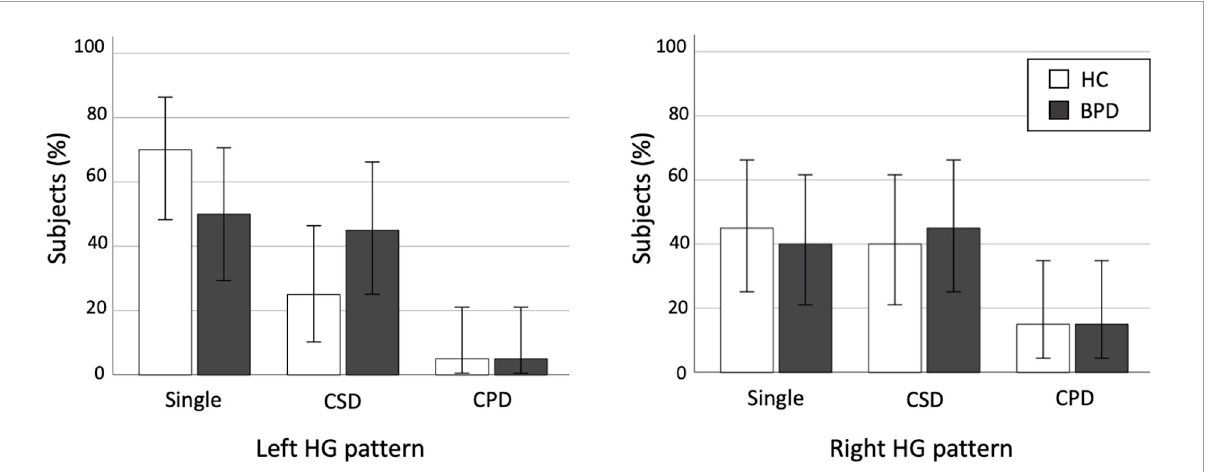
FIGURE2 Distribution of Heschl’s gyrus (HG) duplication patterns in the healthy control (HC) and borderline personality disorder (BPD) groups. CPD, complete posterior duplication; CSD, common stem duplication. Error bars show 95% confidence intervals.